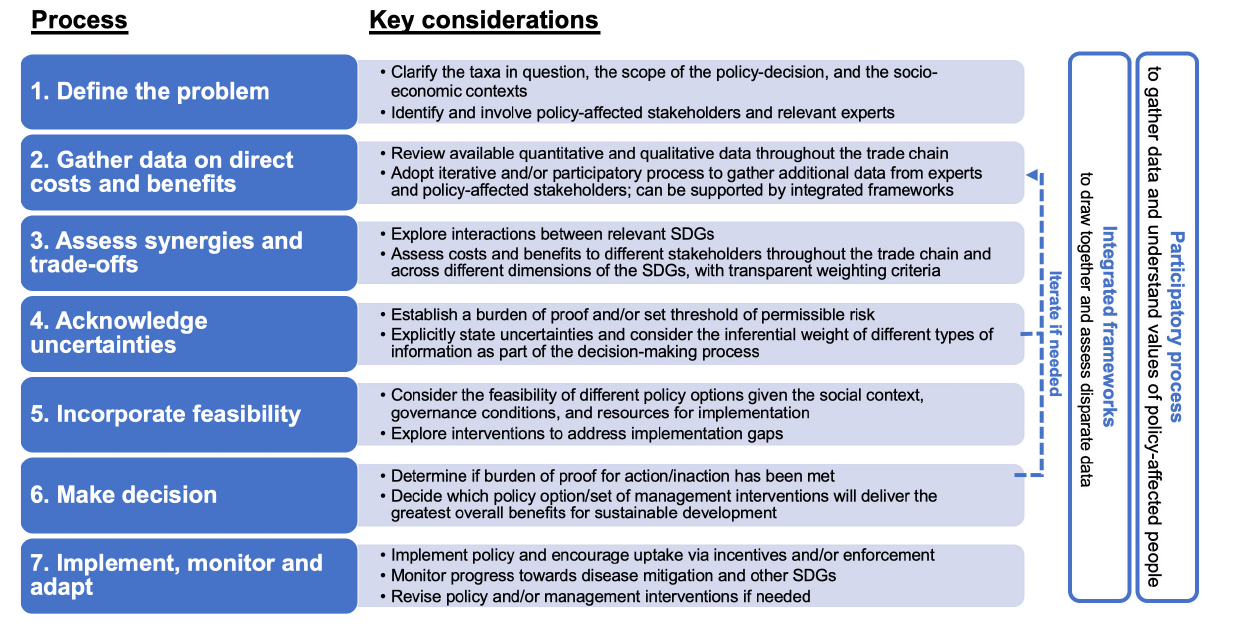
FIGURE 3 | A general process and key considerations for developing risk-based wildlife trade policy for sustainable development outcomes.